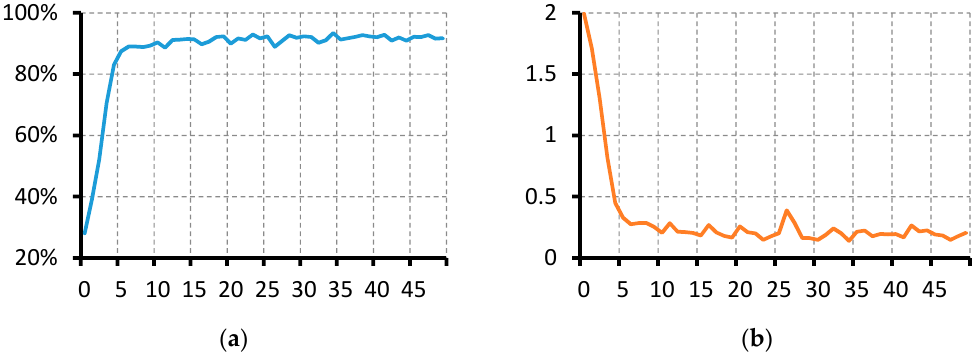
Figure 16. ( a ) Accuracy rate curves and ( b ) loss function value curves during the training process of the proposed model.